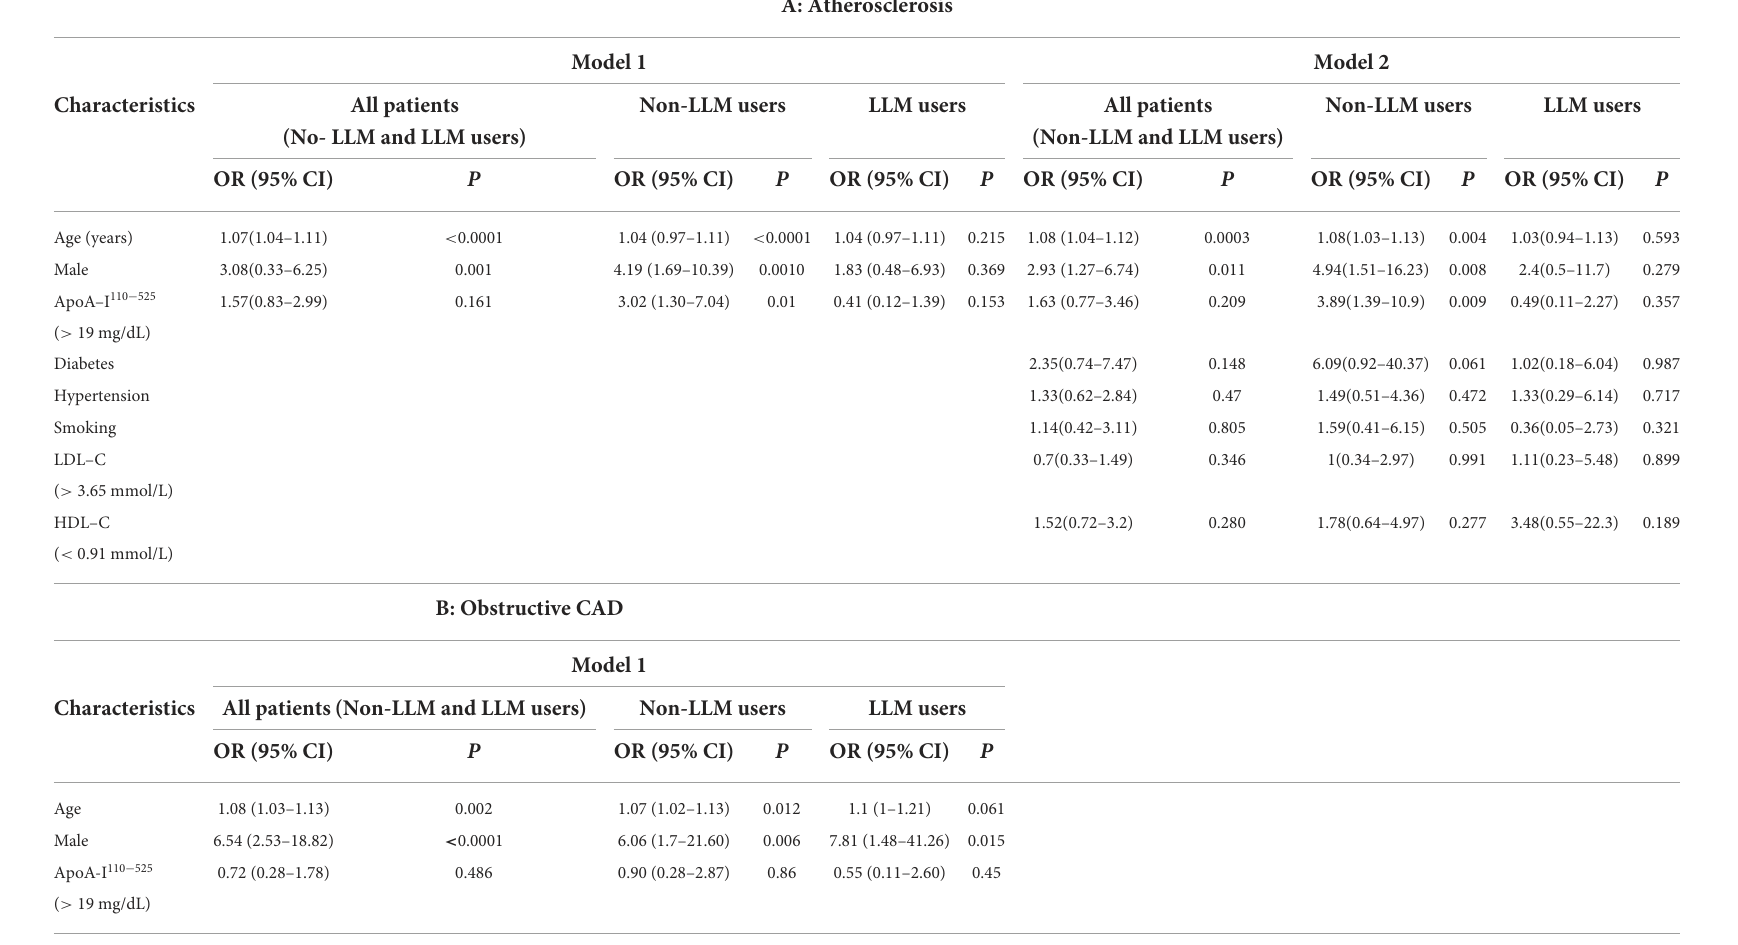
TABLE 3 Multivariate logistic regression analysis of the direct two-site apoA-I assay 110–525 for the presence of atherosclerosis (A) and obstructive CAD (B) in all the patients and separately for patients taking LLM (LLM users) and not taking LLM (non-LLM